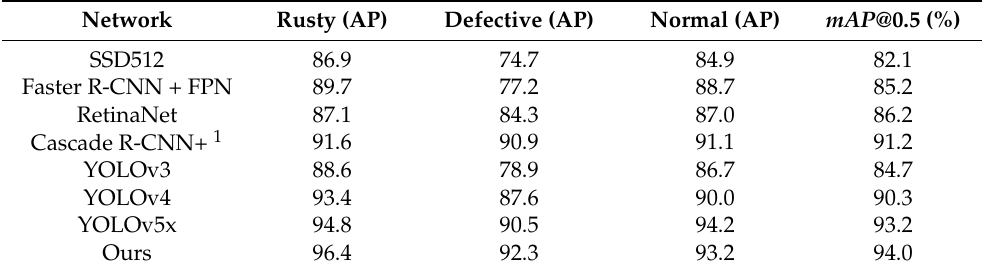
Table 6. Detection results for some mainstream object detection networks.